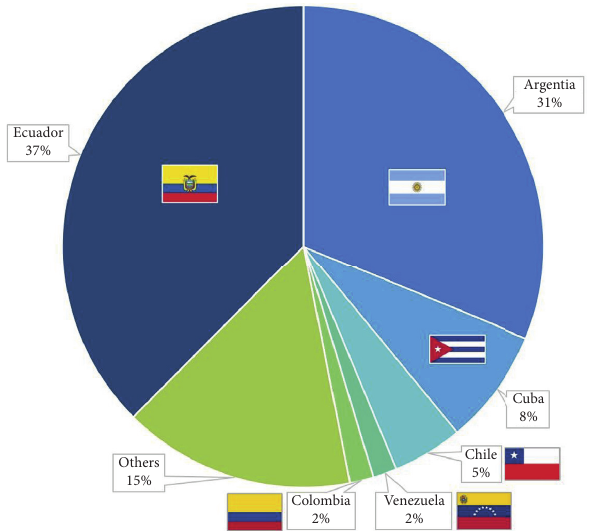
Figure 3: Countries in which rheumatology fellowship was obtained.